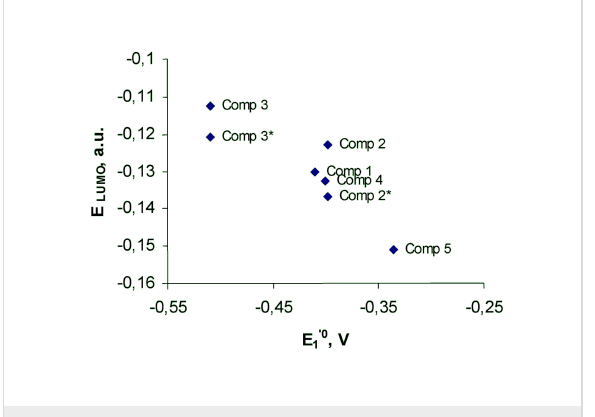
Figure 6: Second formal redox-potentials of compounds 1 – 5 vs. their calculated LUMO+1 energies.